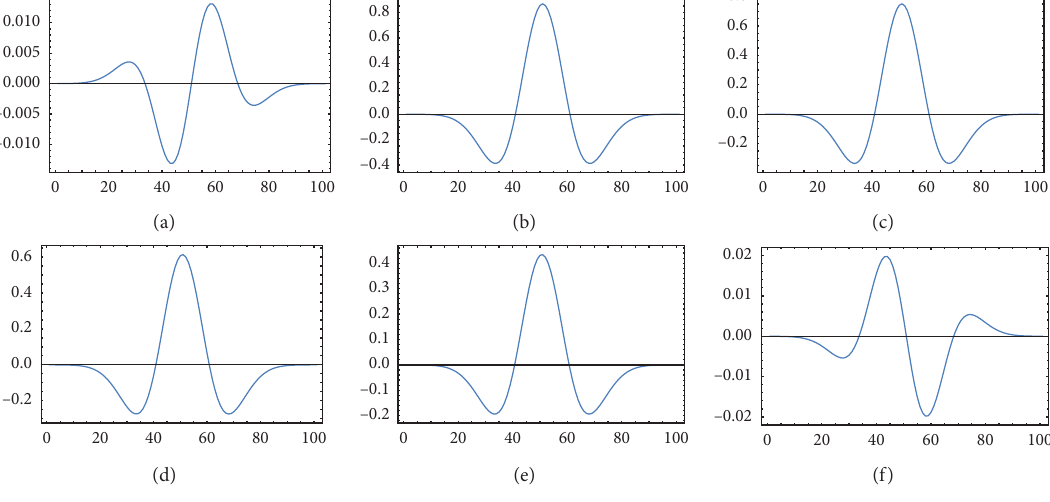
–0.010–0.0050.0000.0050.010